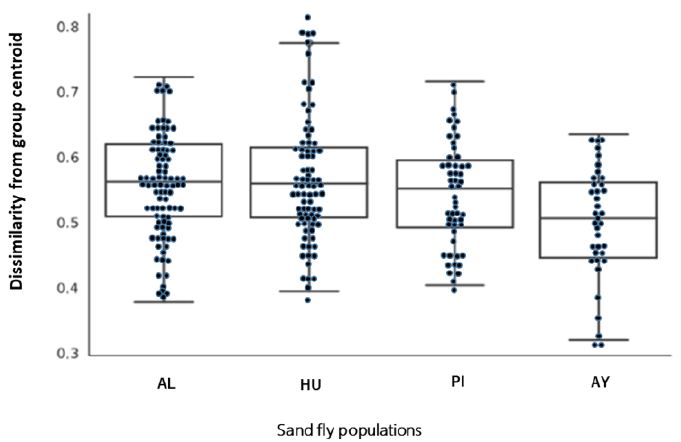
Figure 5. Qiime2 diversity beta- group- significance in Lutzomyia ayacuchensis populations. Ecuador (AL ( n = 90), Alausi; HU ( n = 81), Huigra)); northern Peru (PI ( n = 54), Piura); southern Peru (AY ( n = 36), Ayacucho).